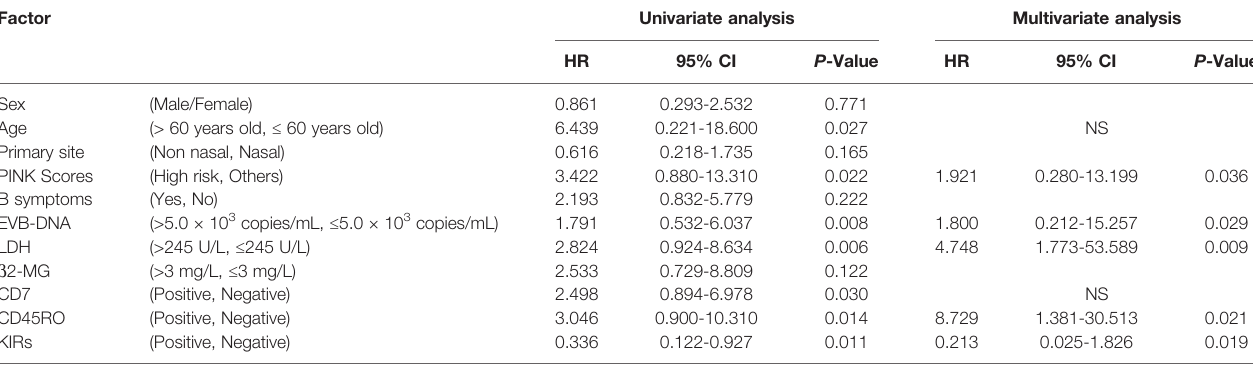
TABLE 4 | Univariate and multivariate Cox regression analysis affecting the survival time of ENKTL. Factor Univariate analysis Multivariate analysis